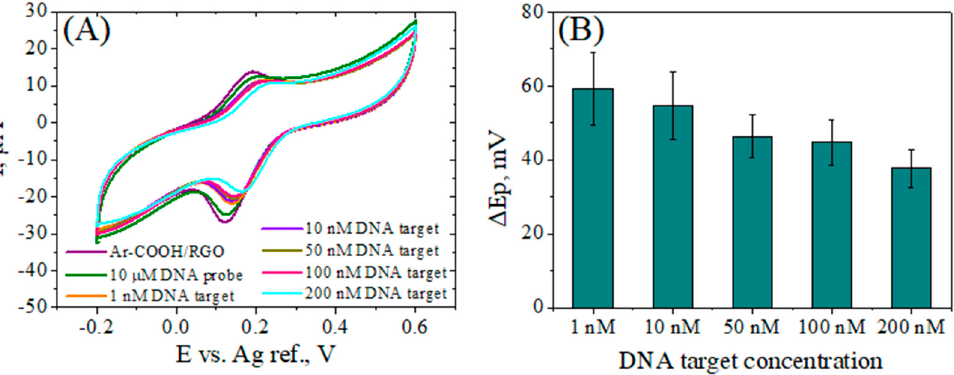
Figure 8. CV curves ( A ) and the corresponding peak separation values, Δ Ep ( B ) of ssDNAp/Ar– COOH/RGO/SPCE after hybridization with different concentration of DNA target, recorded at a scan rate of 0.05 Vs − 1 in 1 mM [Fe(CN) 6 ] 3 − /4 − , 0.1M KCl solution.